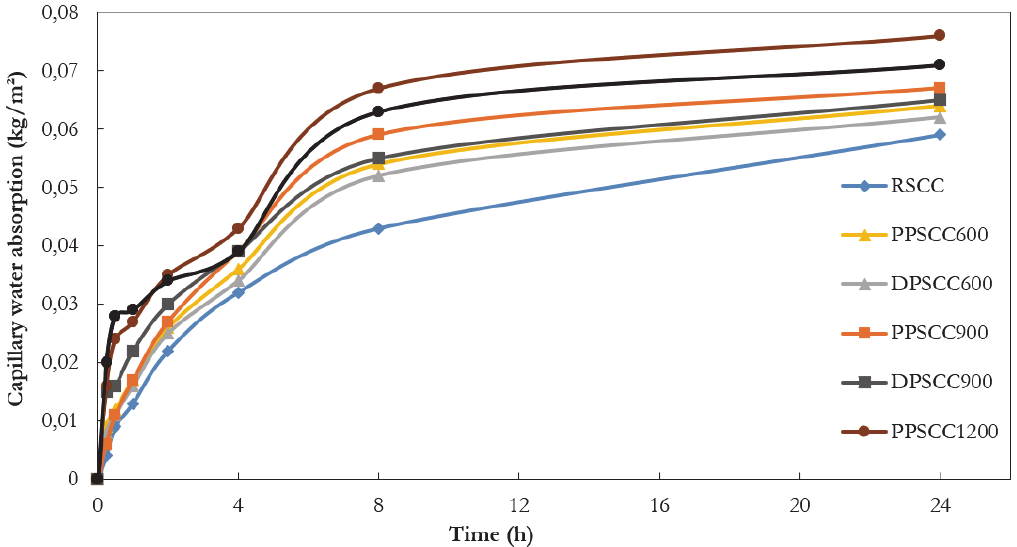
Figure 20: Effect of polypropylene and Date Palm fiber on capillary water